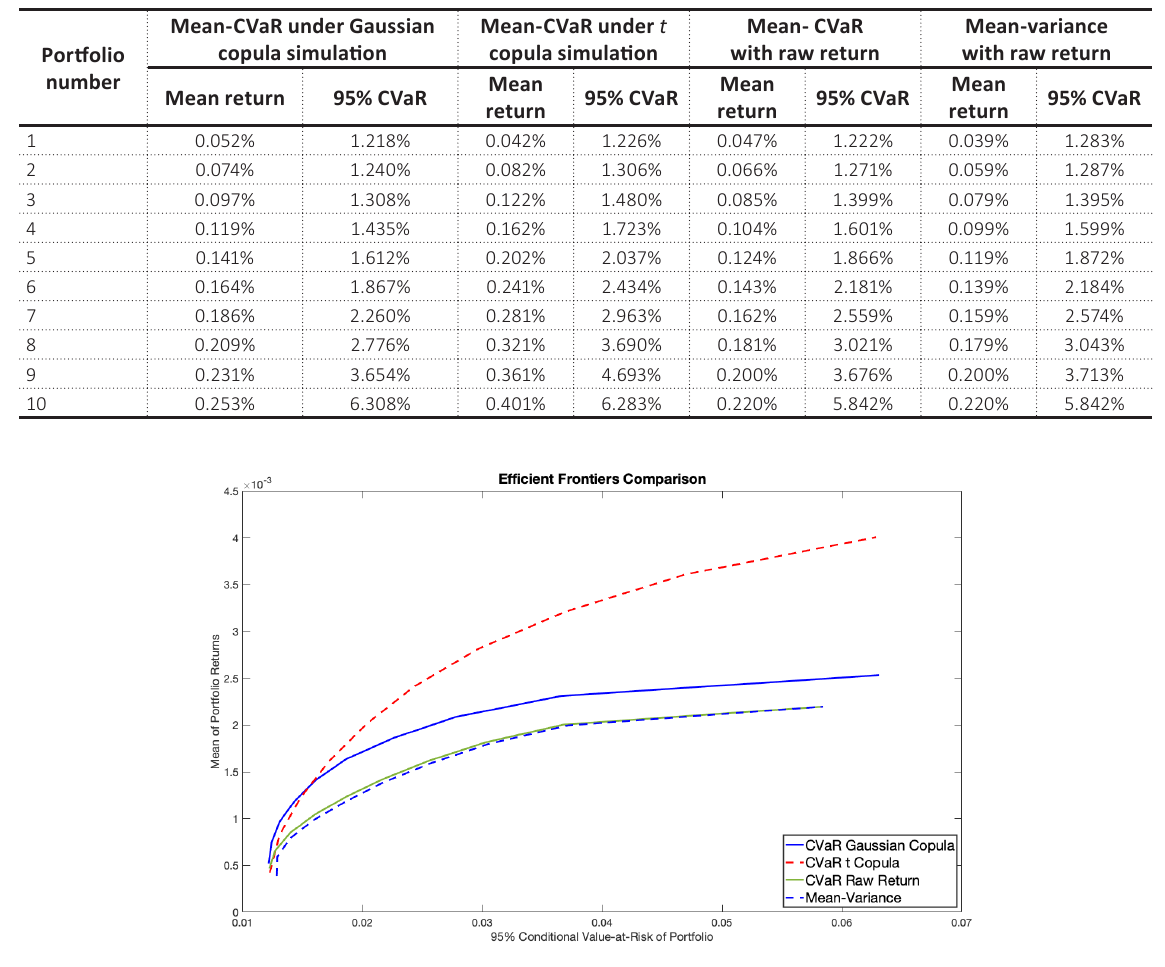
Figure 2. Mean-CVaR efficient frontiers with 95% CVaR (6.5-year